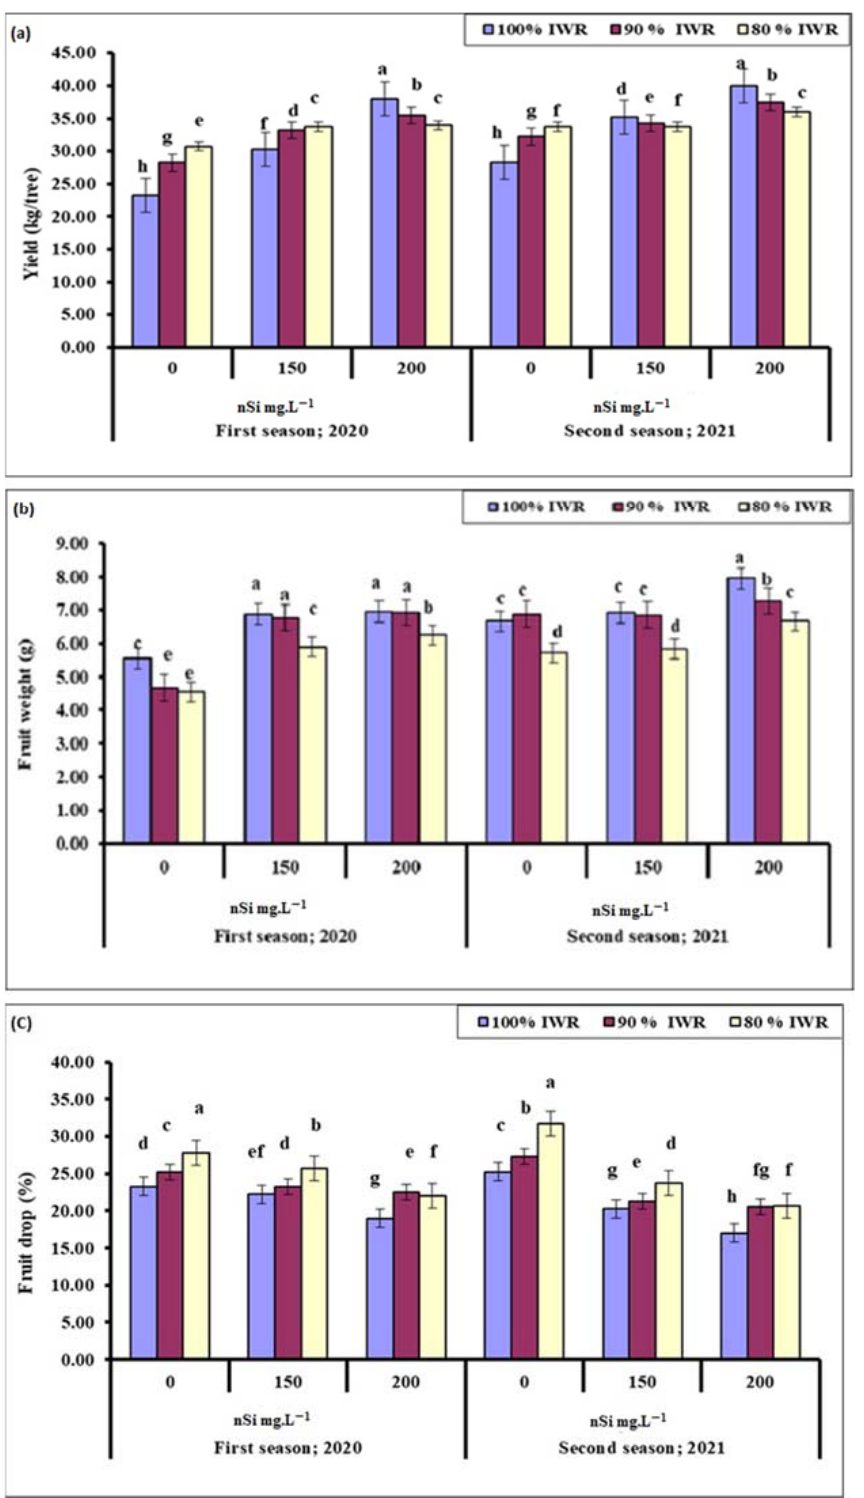
Figure 1. Effect of foliar sprayed nano-silicon (nSi) under different irrigation regimes on the yield ( a ), fruit weight ( b ) and fruit drop ( c ) of ‘Kalamata’ olive trees during the 2020 and 2021 seasons ( n = 10). Means with similar letters for each season are not significantly different, using Duncan’s multiple range test (DMRT) at p ≤ 0.05. Error bars represent the standard error of the means.